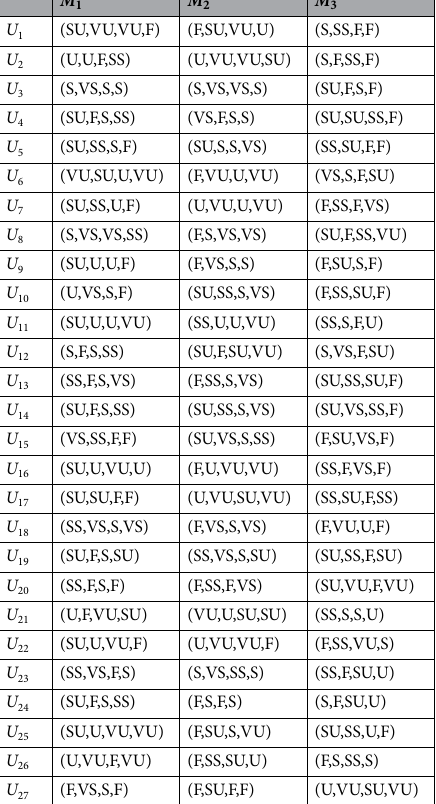
Table 5. LDM for SIBO